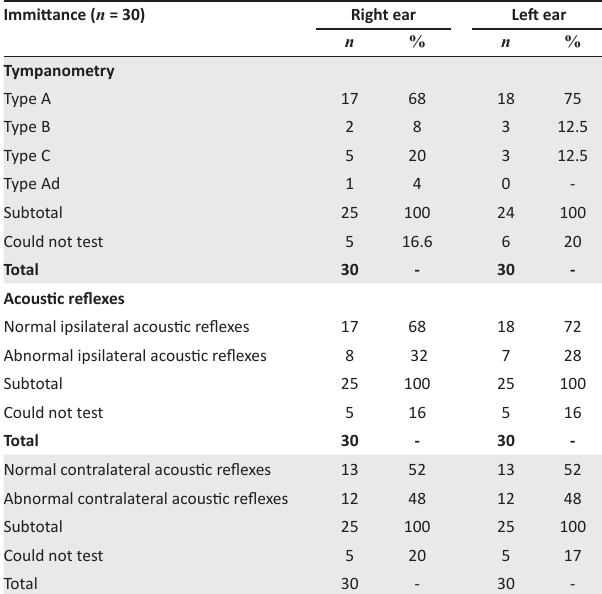
TABLE 2: Immittance audiometry